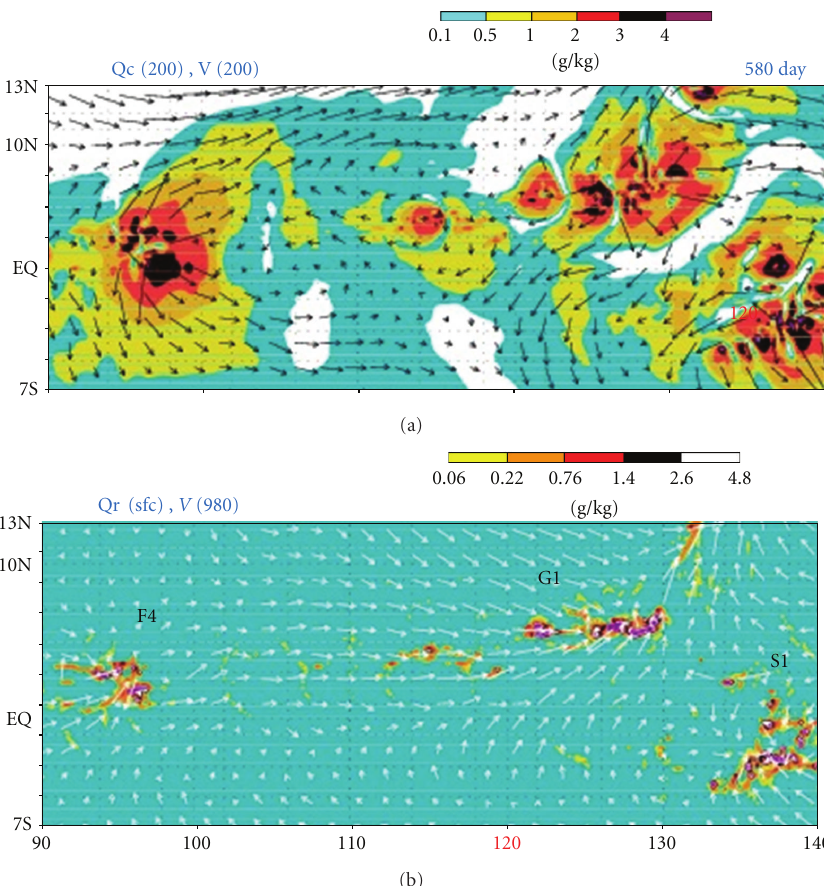
Figure 12: Horizontal distribution of the low-level rainwater mixing ratio (lower panel), and the upper-level (200hPa) cloud water mixing ratio (upper panel) at 580 day in case (R). Wind vectors are also shown. Cloud clusters F4, G1, and S1 are